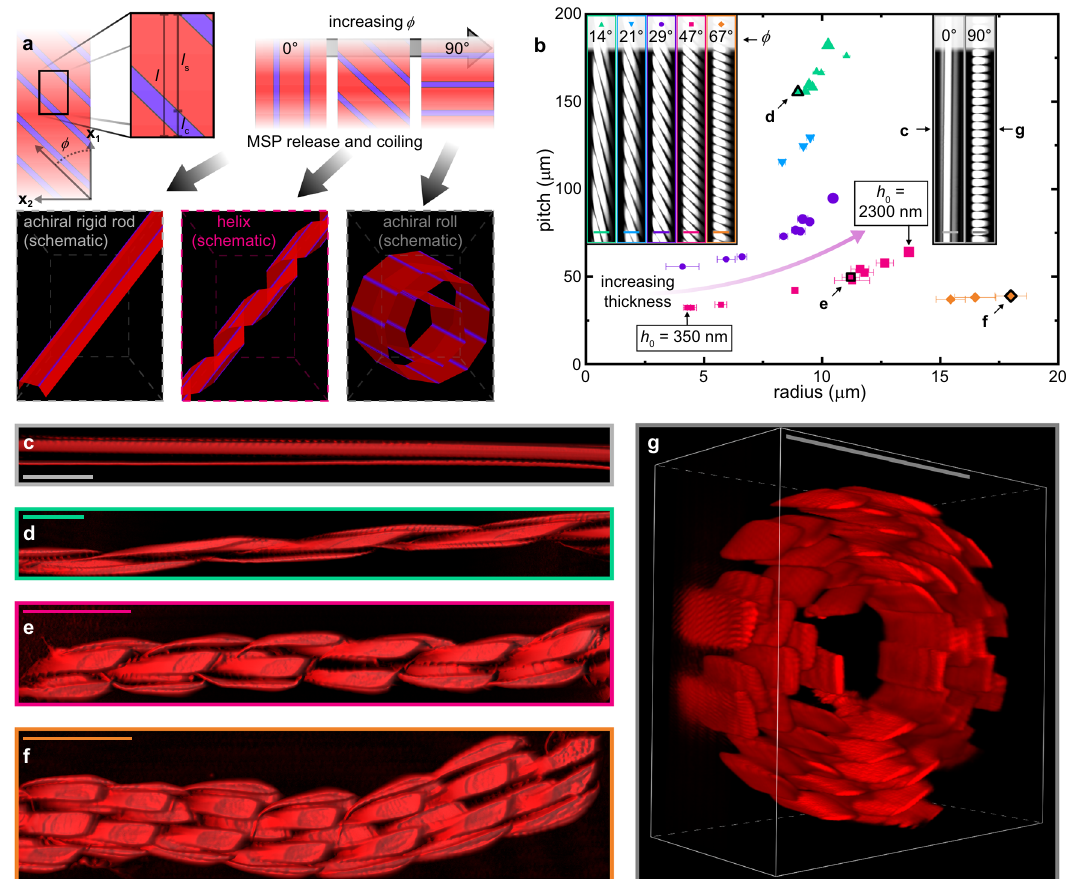
Fig. 3 | MSP coiling. a schematic of anticipated 3D structures arising from pho- tocrease bending for ϕ =0° (left), 0°< ϕ < 90° (center), and ϕ =90° (right); only intermediatevaluesof ϕ areexpectedtoaffordhelices. b helixpitchasafunctionof helix radius for ϕ =14°, 21°, 29°, 47°, and 67°. For ϕ =29° and 47°, increasing thickness ( h 0 ~350 – 2300nm) affords increasing pitch and radius; data point size scales with h 0 . Error bars represent 1 standard deviation of the sample summed in quadrature with rms displacement from fi tted helix; 3 highlighted data points